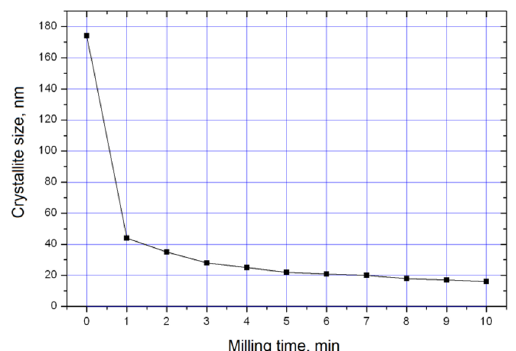
Figure 5. The dependence of the titanium crystallite size on the milling time of the Ti + 0.3C powder mixture.